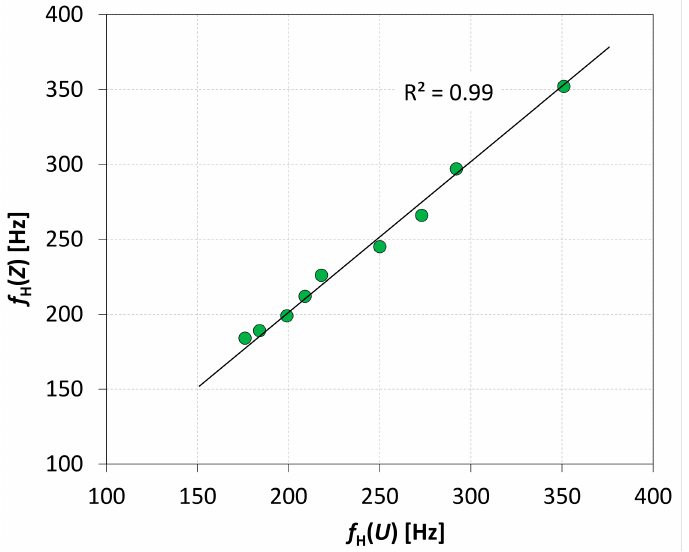
Figure 6. Comparison of Helmholtz resonance frequencies received from various measurement